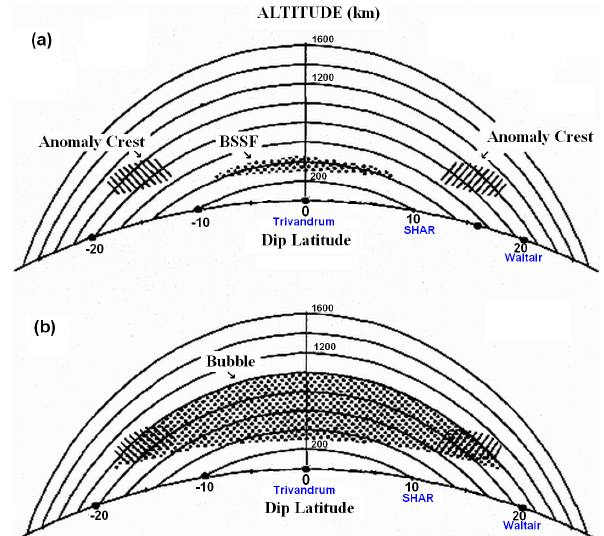
Fig. 1. Illustration showing the distinction between bottom side spread-F (BSSF) and the plasma bubbles as a function of latitude and the geomagnetic field. (a) BSSF (shown with dot pattern) is confined to below the F layer maximum and extends along the magnetic field lines to a narrow belt in latitude detectable only by the ionospheric sounders near the dip equator (Trivandrum and/or SHAR). (b) An equatorial plasma bubble that rises to high altitude and extends along the magnetic field lines to higher latitudes, de- tected by all three sounders (Trivandrum, SHAR and Waltair) (after Whalen,